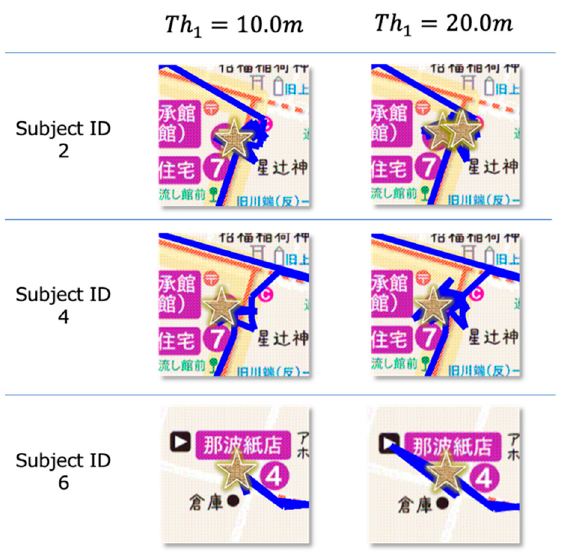
Figure 13. Results at which points of staying indoors were recognized with two different threshold settings, i.e., Th 1 = 10.0 m ( left ) and Th 1 = 20.0 m ( right ). Due to the user experiments, (cid:1846)ℎ (cid:2869) (cid:3404) 10.0(cid:1865) was found to be an appropriate value to generate the